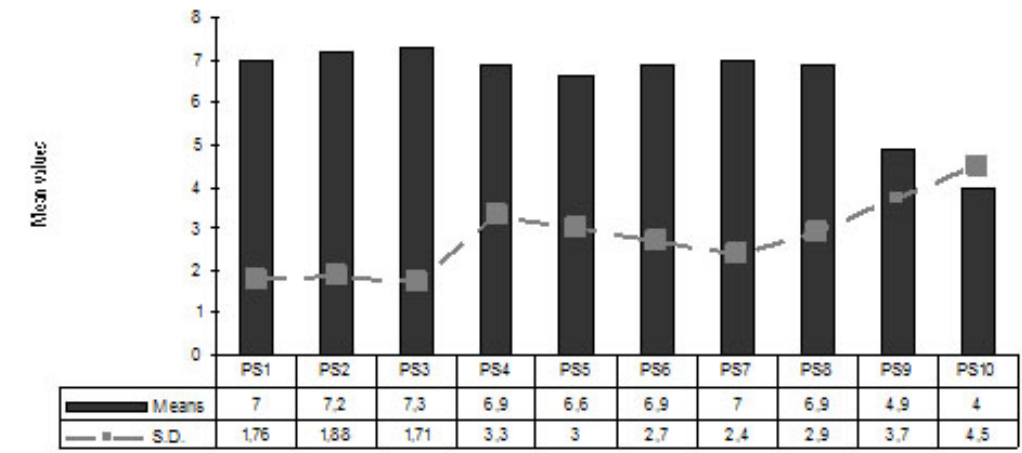
Figure 3. Learning Activity